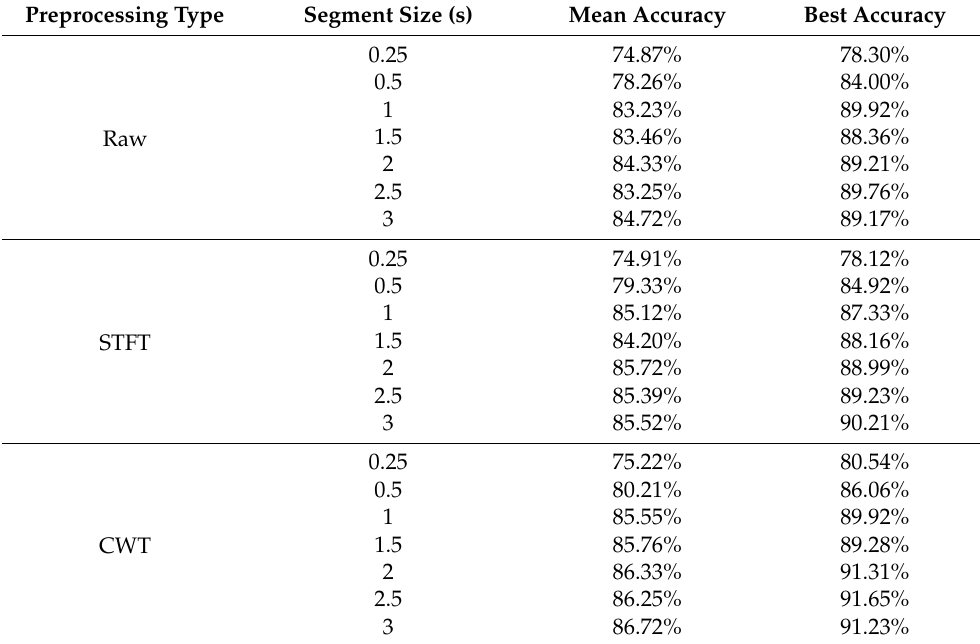
Table 4. Classification accuracy of different input lengths.